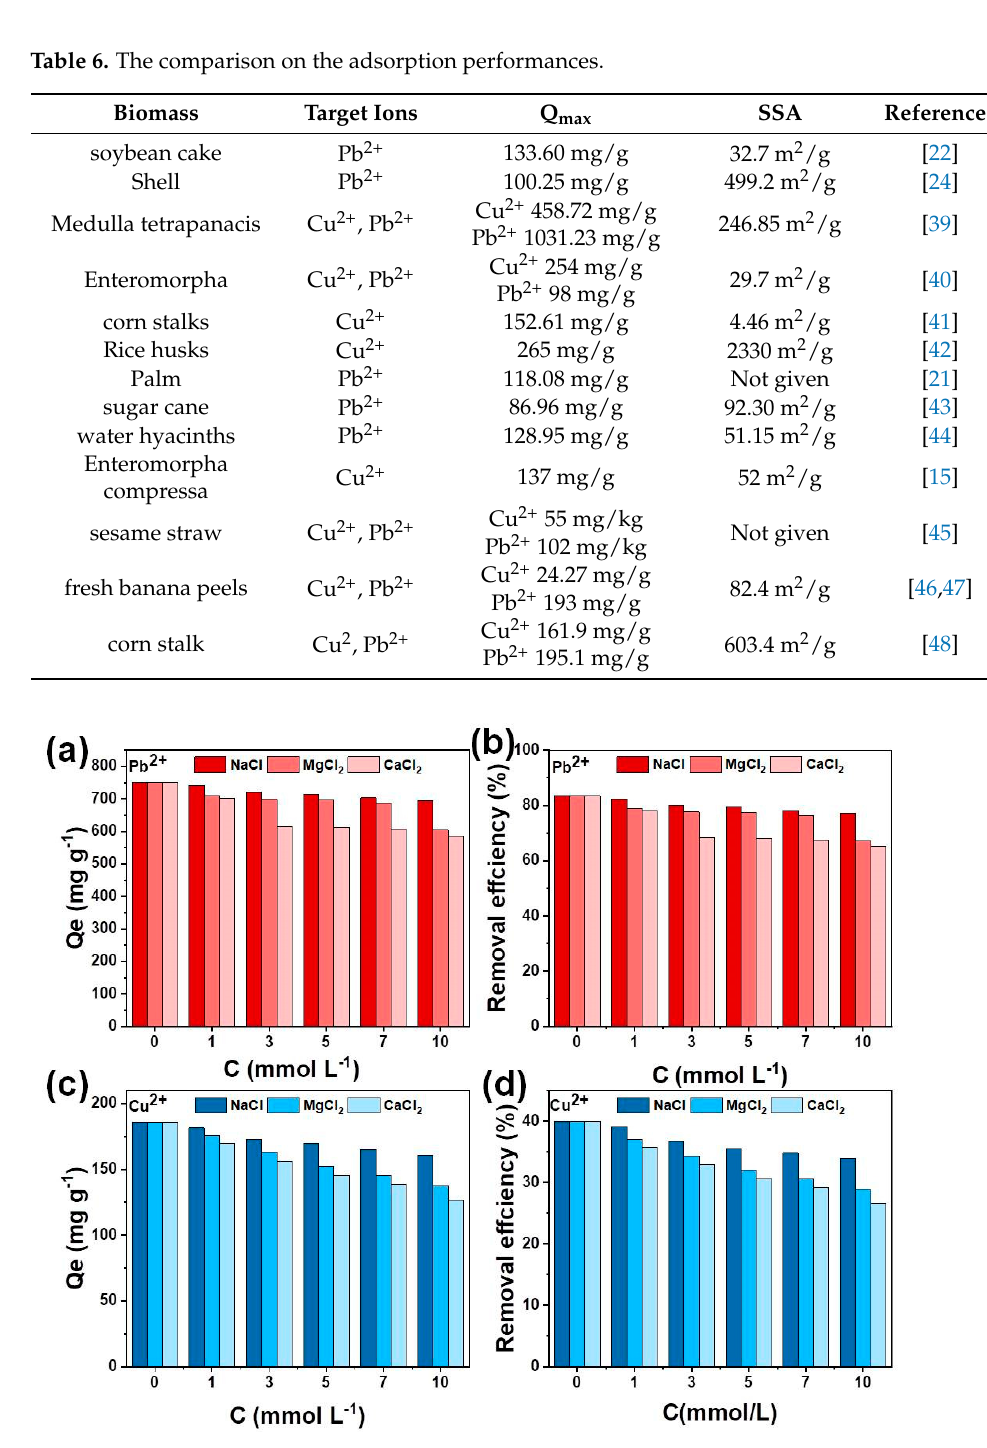
Figure 9. The effect of background ions on the sorption of (a) HSC-MA-2 and (b) HSC-N2 on Pb 2+ , and (c) HSC-MA-2 and (d) HSC-N2 on Cu 2+